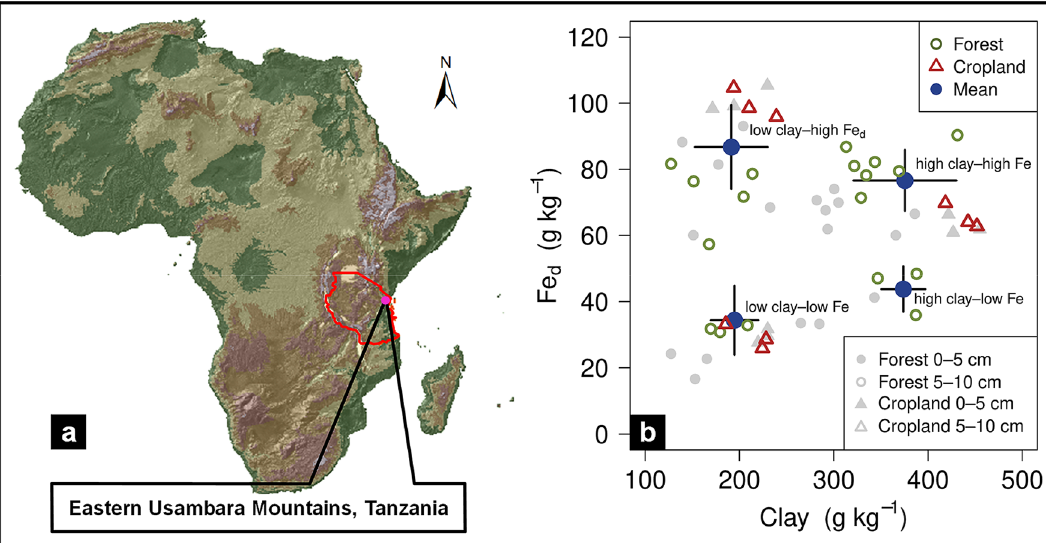
Figure 1. ( a ) Study site location in the Eastern Usambara Mountains of Tanzania. This map was created using the software ArcGIS version 10.3; https:// deskt op. arcgis. com/ de/ arcmap/; ( b ) total sample set showing the combinations of aluminous clay (clay) and pedogenic Fe oxides (Fe d ) at the study site ( n = 54). Aluminous clay represents the weight sum of kaolinite and gibbsite present in the < 2-µm fraction, and pedogenic Fe oxides are represented by dithionite-bicarbonate-citrate-extractable Fe. The depth of 5–10 cm (open colored circles and triangles) was used to assign samples to one of the mineralogical combinations. Large blue dots show the respective combination means, while whiskers represent the associated standard